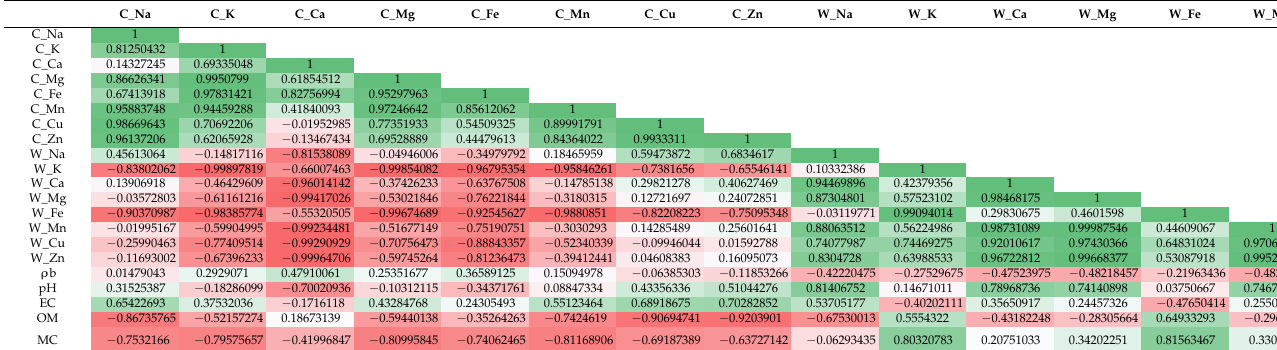
Table A1. Correlation coefficients between elemental composition nutrient content, water extractable nutrient content and physical and chemical properties of AP.